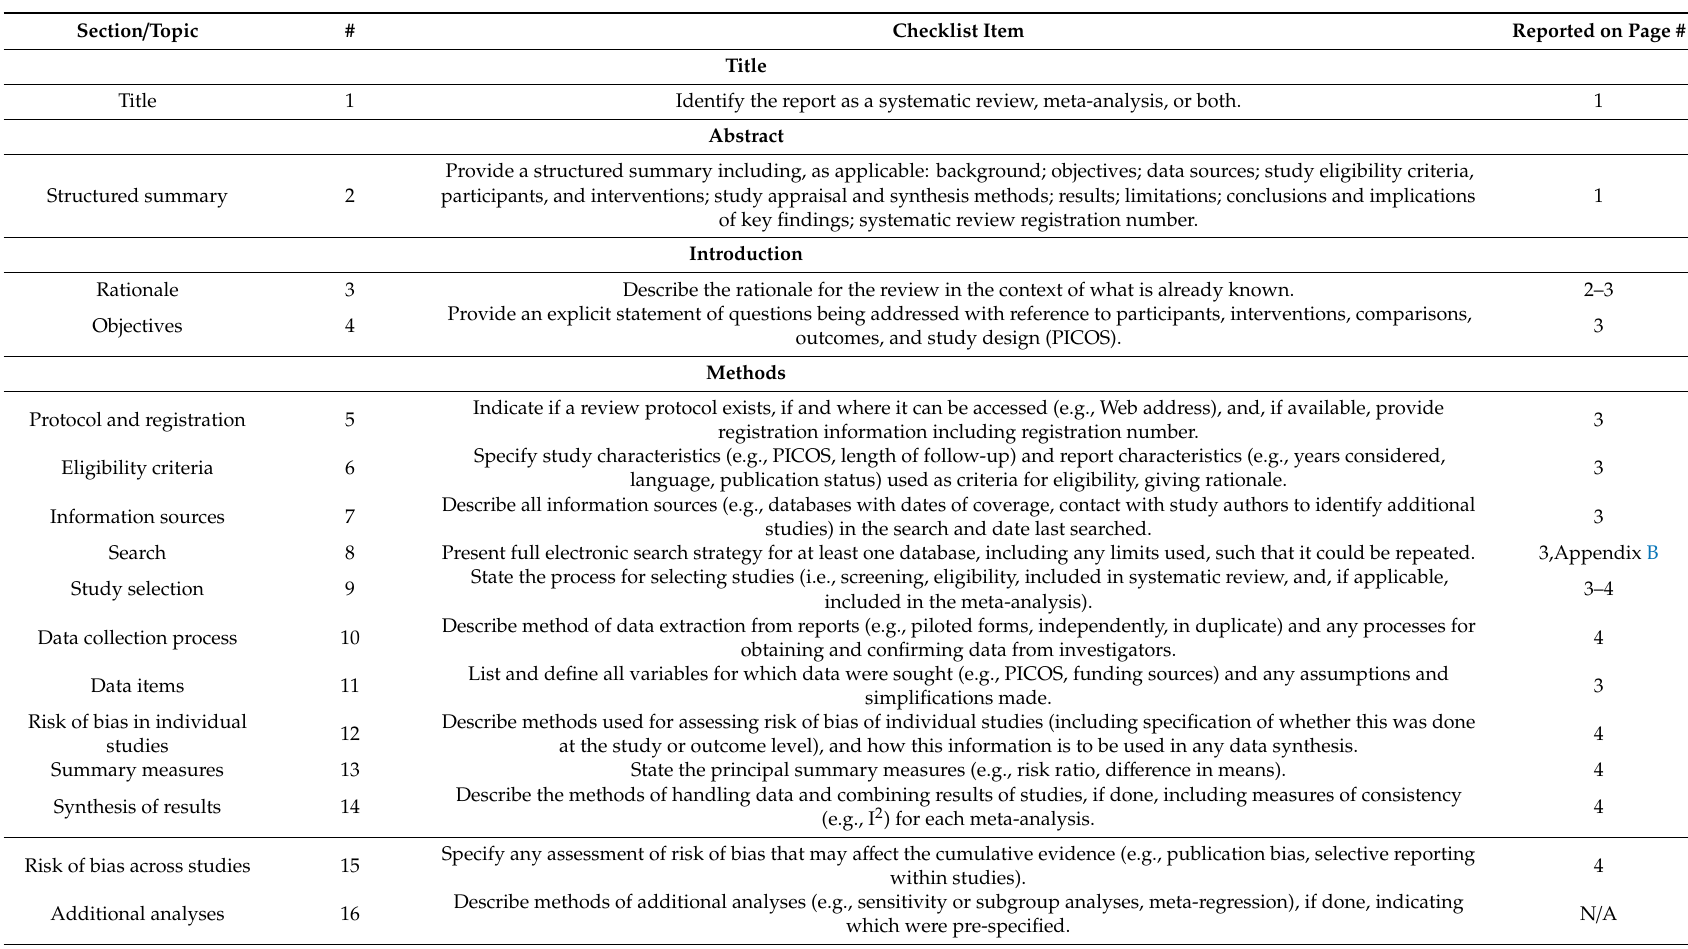
Table A1. PRISMA 2009